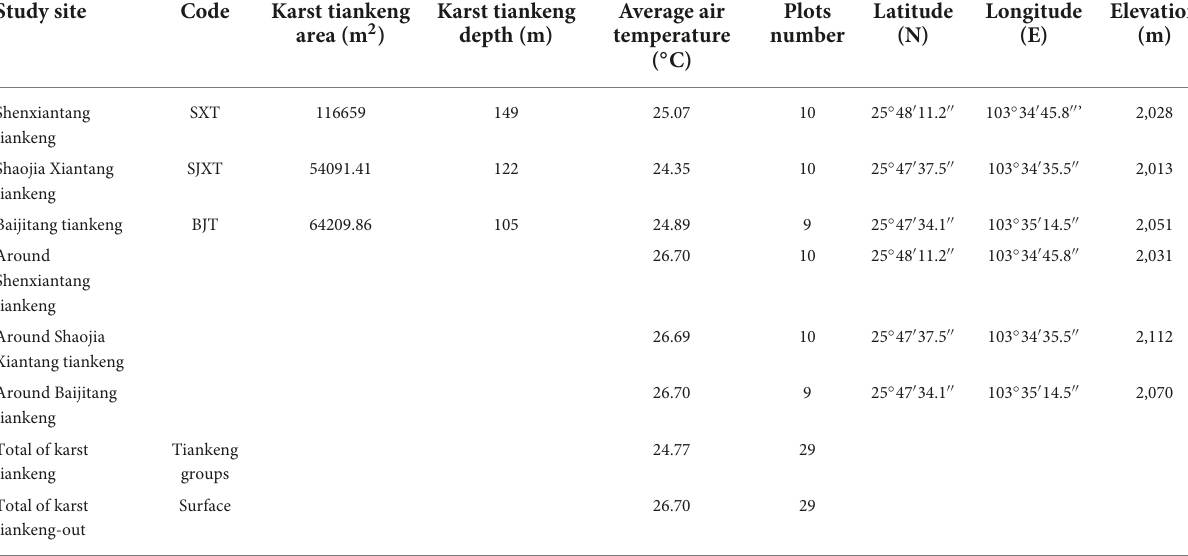
TABLE 1 List of study sites within and outside the karst tiankeng forests region of southwest China. Study